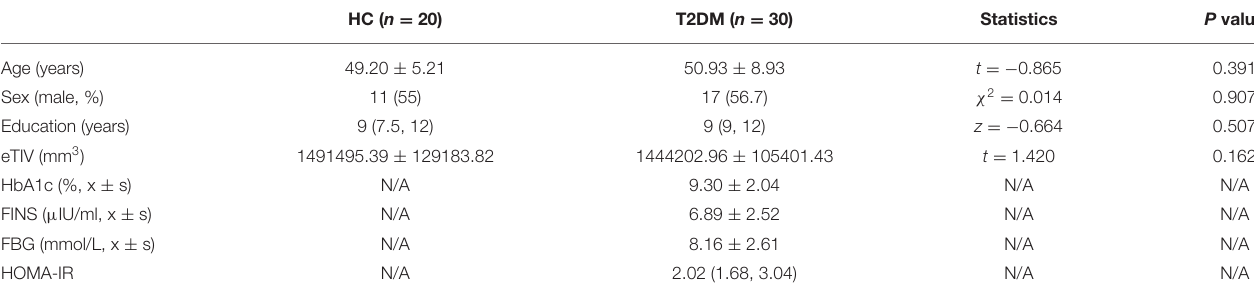
TABLE 1 | Demographic data and clinical biochemical indicators of all subjects.